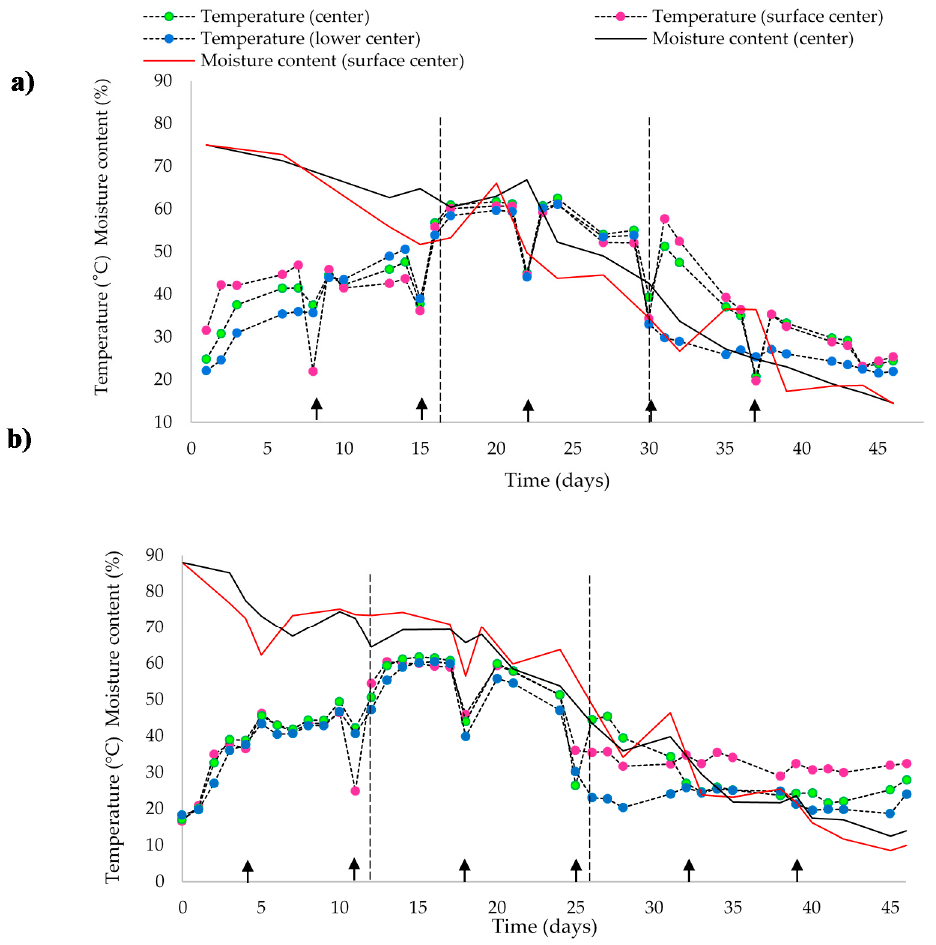
Figure 2. Behavior of temperature and moisture during the biodrying process in P1 ( a ) and P2 ( b ). Arrows indicate turnings.